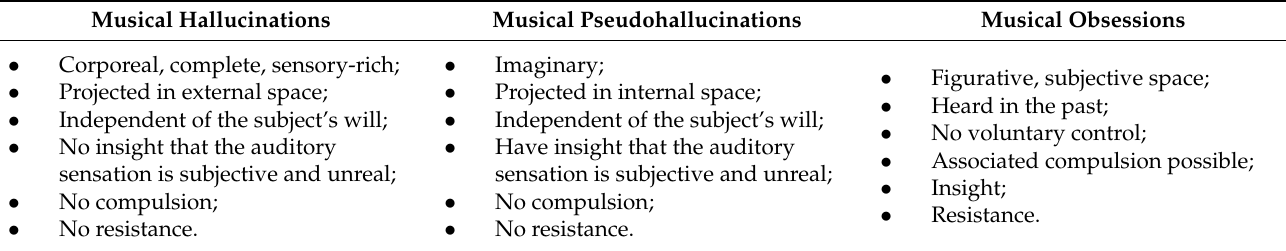
Table 1. Characteristics of musical hallucinations, pseudohallucinations and obsessions [30]. Musical